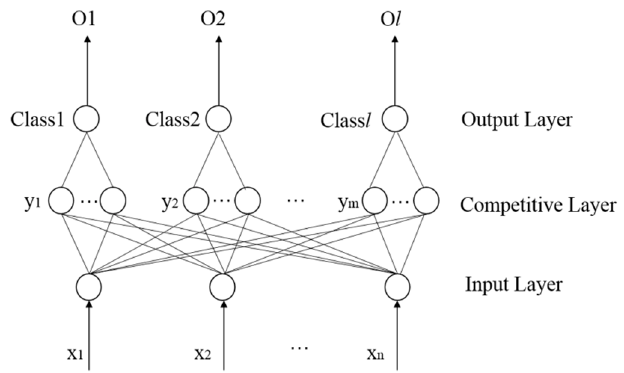
Figure 5. LVQ neural network structure.